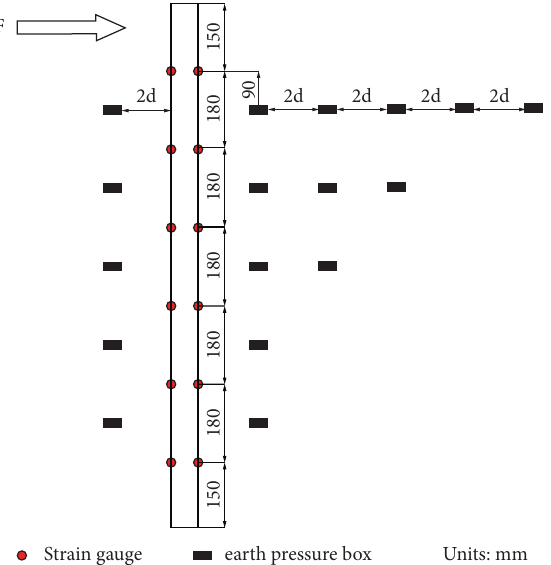
Figure 2: Strain gauge distribution of pile body. Figure